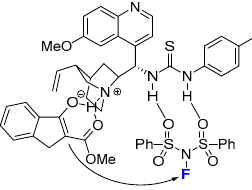
Figure 7. Plausible intermediate proposed by Hu [59].